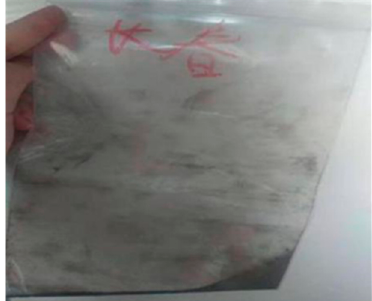
Figure 1. Blockage sample.